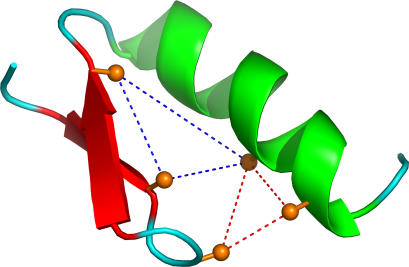
Important Triplet Clusters for the Expansion of Zinc-Finger EnergiesOrange balls represent the location of the Cβ atoms of side chains. Two clusters are shown, one in red and one in blue.